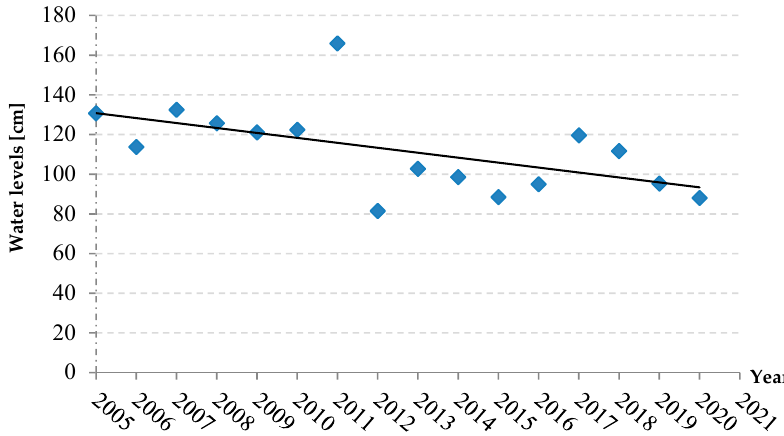
Figure 3. Surface water levels in the Go ł dap region in 2005–2021 in Poland, [27]. The surface water level in the Go ł dap region will decrease every year (Figure 2). The obtained data, both the sum of daily precipitation in the Gołdap region (Figure